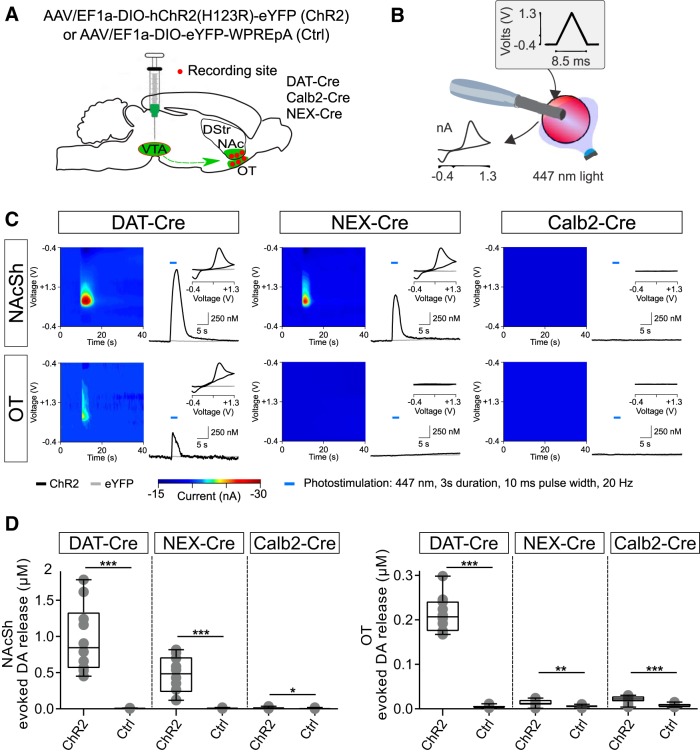
Optogenetic stimulation in striatal target areas of NeuroD6 and Calb2 VTA neurons verifies DA release. A, Schematic representation of stereotaxic injection into VTA of Cre-dependent DIO-ChR2-eYFP and DIO-eYFP (Ctrl); FSCV recording sites within NAcSh and OT (red dots). B, Illustration of the experimental setup. C, Representative light-evoked DA recordings from injected DAT-Cre (left), NEX-Cre (middle), and Calb2-Cre (right) mice in the NAcSh (top) and the OT (bottom). D, Quantification of photostimulation-evoked DA release in the NAc shell (left) and OT (right); N = 10 recording sites per group for each region. Mice used for the recordings: DAT-Cre/ChR2 N = 2, DAT-Cre/eYFP N = 2, NEX-Cre/ChR2 N = 3, NEX-Cre/eYFP N = 2 Calb2-Cre/ChR2 N = 3, and Calb2-Cre/eYFP N = 2. Box and whisker plots, Center lines indicate medians, box edges represent the interquartile range, whiskers extend to the minimal and maximal values (*p < 0.05, **p < 0.01, ***p < 0.001 ChR2 vs ctrl). DStr, dorsal striatum; NAcSh, nucleus accumbens shell; OT, olfactory tubercle. DAT, Dopamine transporter; Calb2, Calbindin 2 (Calretinin); ChR2; Channelrhodopsin 2; eYFP, enhanced Yellow fluorescent protein; NEX, NeuroD6.